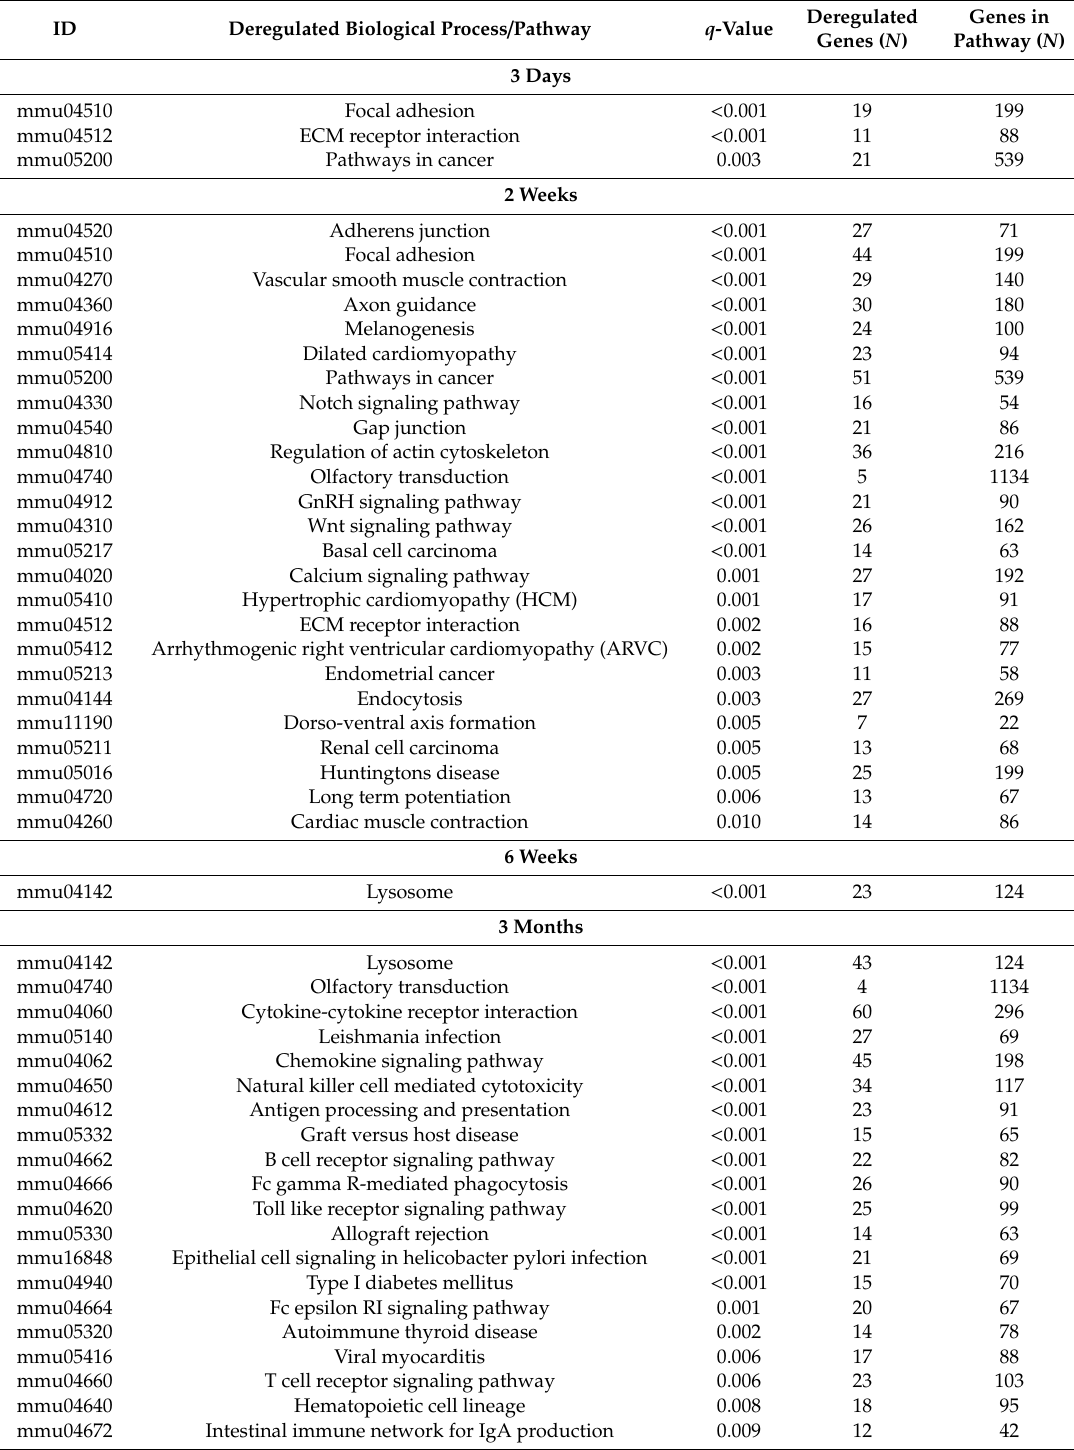
Table 4. Kyoto Encyclopedia of Genes and Genomes (KEGG) pathways based on miRNA–mRNA interactions deregulated after inhalation of CuO